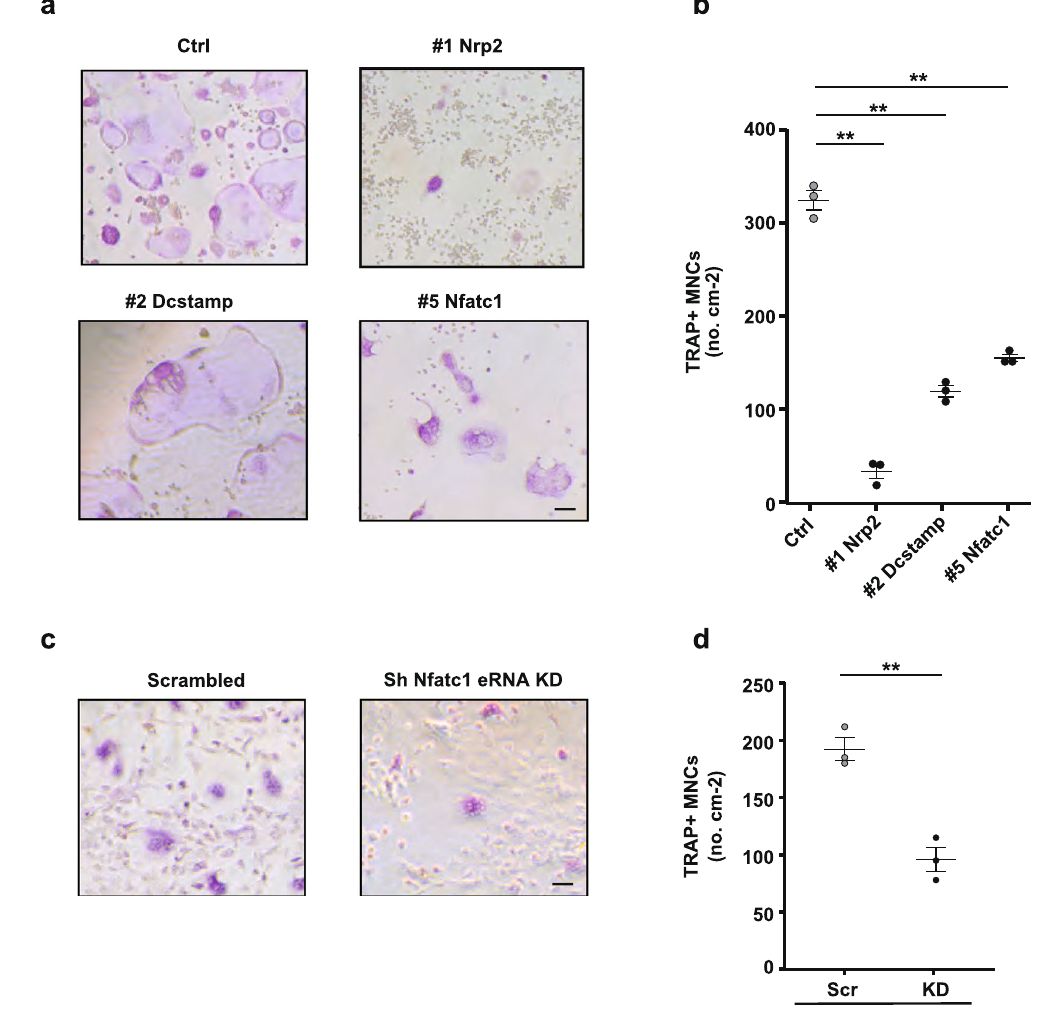
Figure 5. The effect of eRNA on osteoclast differentiation. ( a ) Tartrate-resistant acid phosphatase (TRAP)- stained cells showing osteoclast differentiation in control and knockout cells. ( b , d ) The numbers of TRAP-positive cells with more than three nuclei were counted. (c) TRAP-stained cells showing osteoclast differentiation mediated-knockdown with sh-scrambled (Scr) and sh-Nfatc1 eRNA as in Fig. 4d. Scale bars, 100 μ m. Data denote the mean ± SEM from three independent biological replicates (n = 3) for each group. ** P < 0.01 [Dunnett’s test for ( b ) together with #3 and 4 Dcstamp mutants; the rest of the results are shown in Supplementary Figure S2d; Student’s t -test for ( d )]. The experiments were carried out three